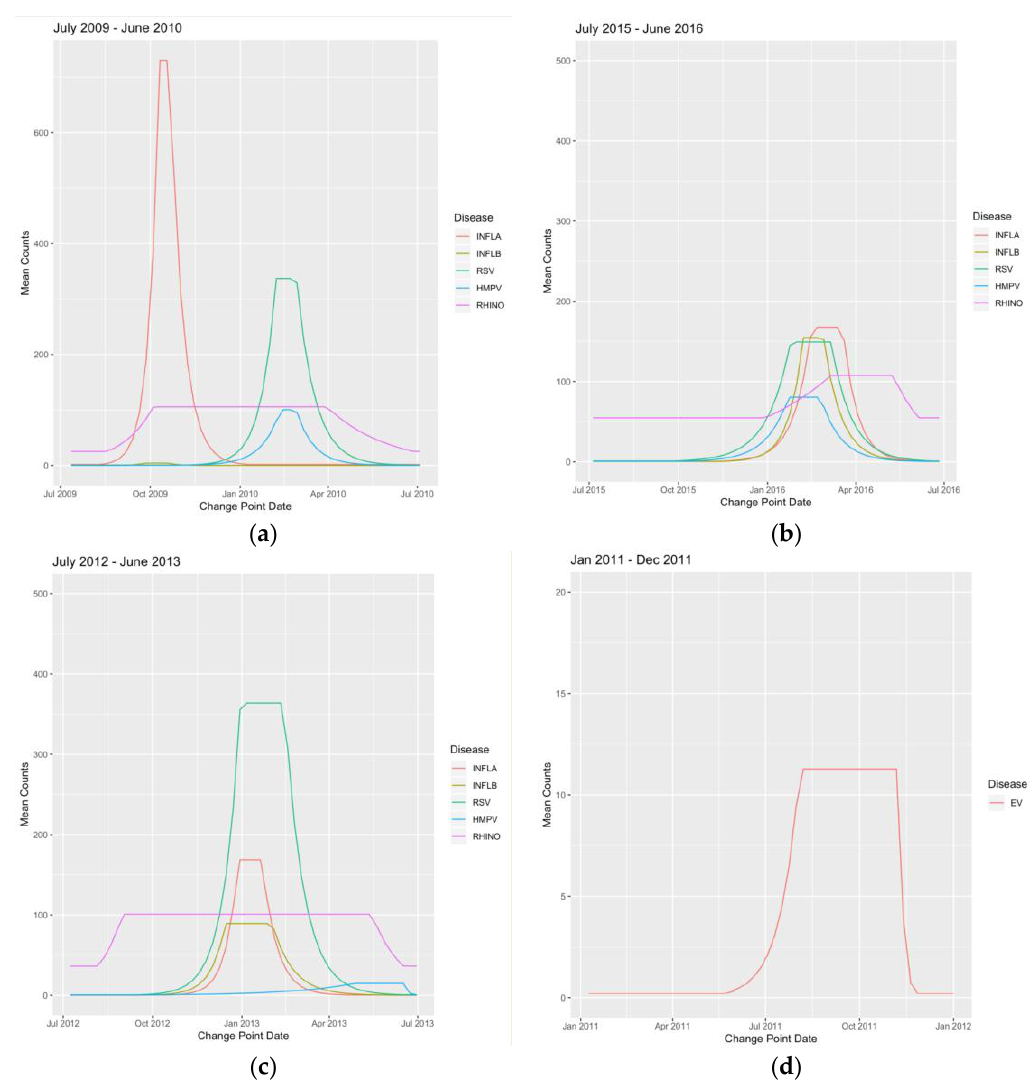
Table A3 for all virus change point values and dates. See Figures A1 and A2 for all virus change point plots.) Viruses 2020 , 12 , x FOR PEER REVIEW